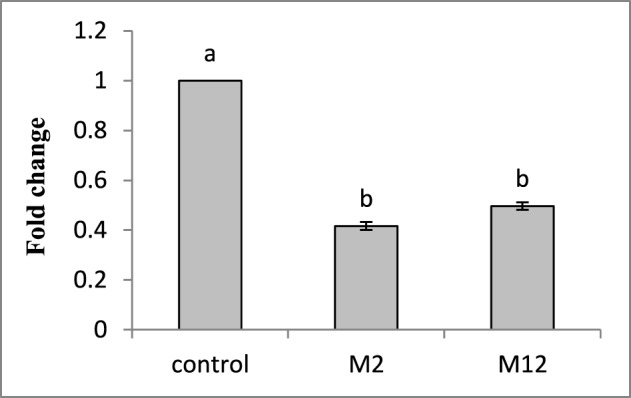
Transcript levels of Mi-cpl-1 gene in M. incognita females that developed in the dsRNA expressing transgenic tomato lines. Using 18S rRNA gene as reference, expression was quantified as fold change values calculated by 2-ΔΔCT method. Each bar represents the mean ±SE of n = 3, and bars with different letters denote a significant difference at P < 0.05, student's t-test.